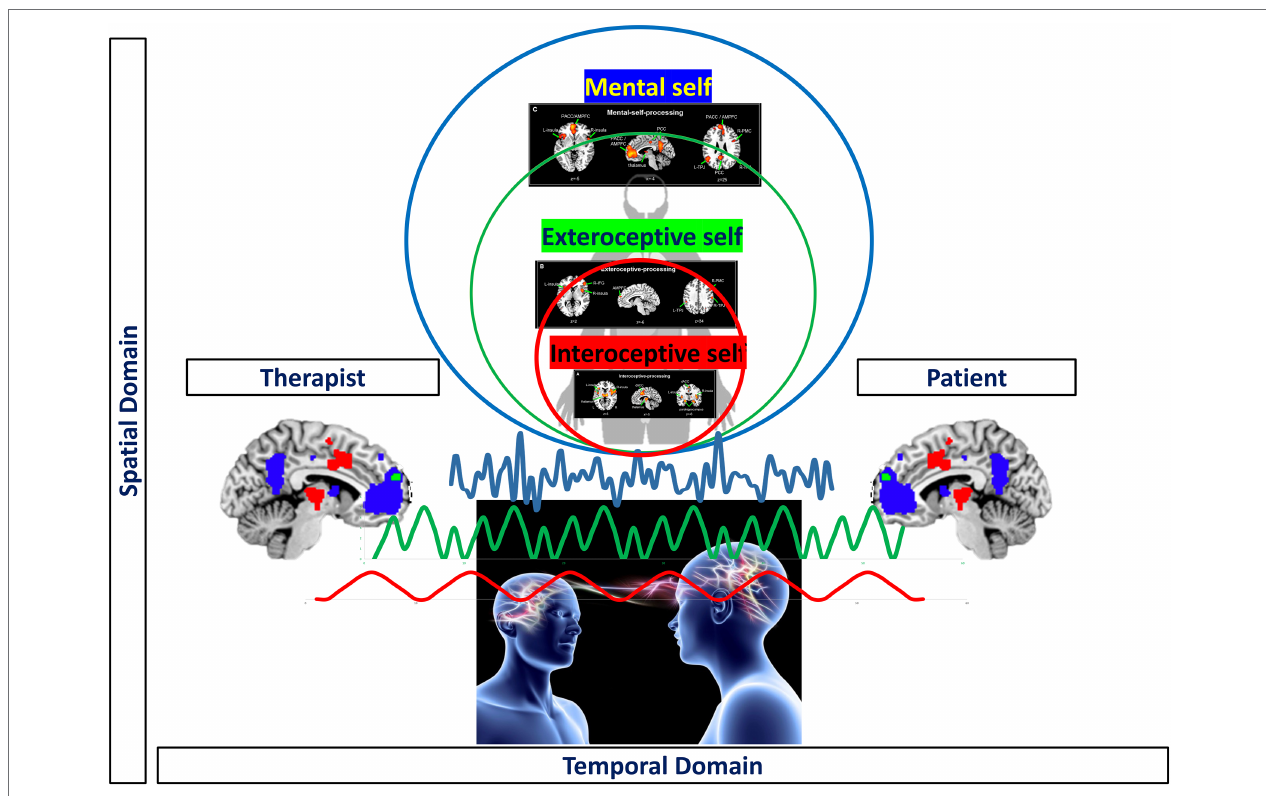
FIGURE 10 | Visual representation of spatiotemporal